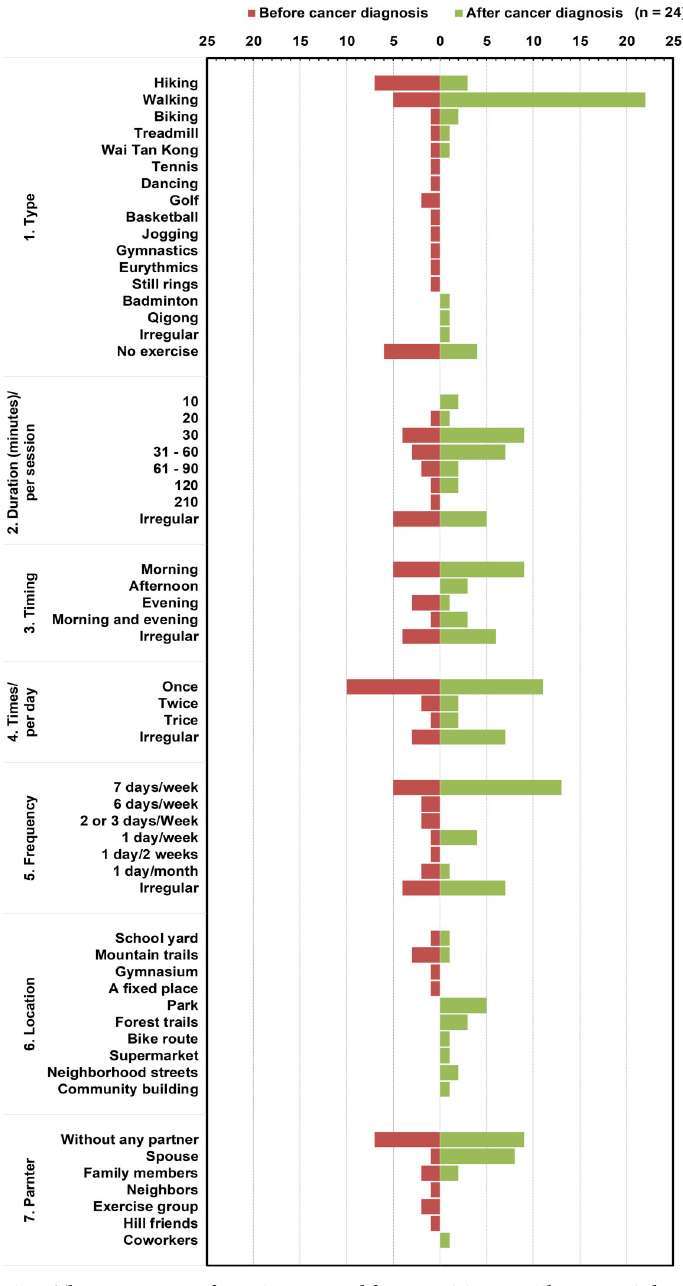
Fig 1. The components of exercise extracted from participants with metastatic lung cancer. Irregular is defined that participants adopted various duration, timing, times, and frequencies in combination with exercise types, locations, or accompanying